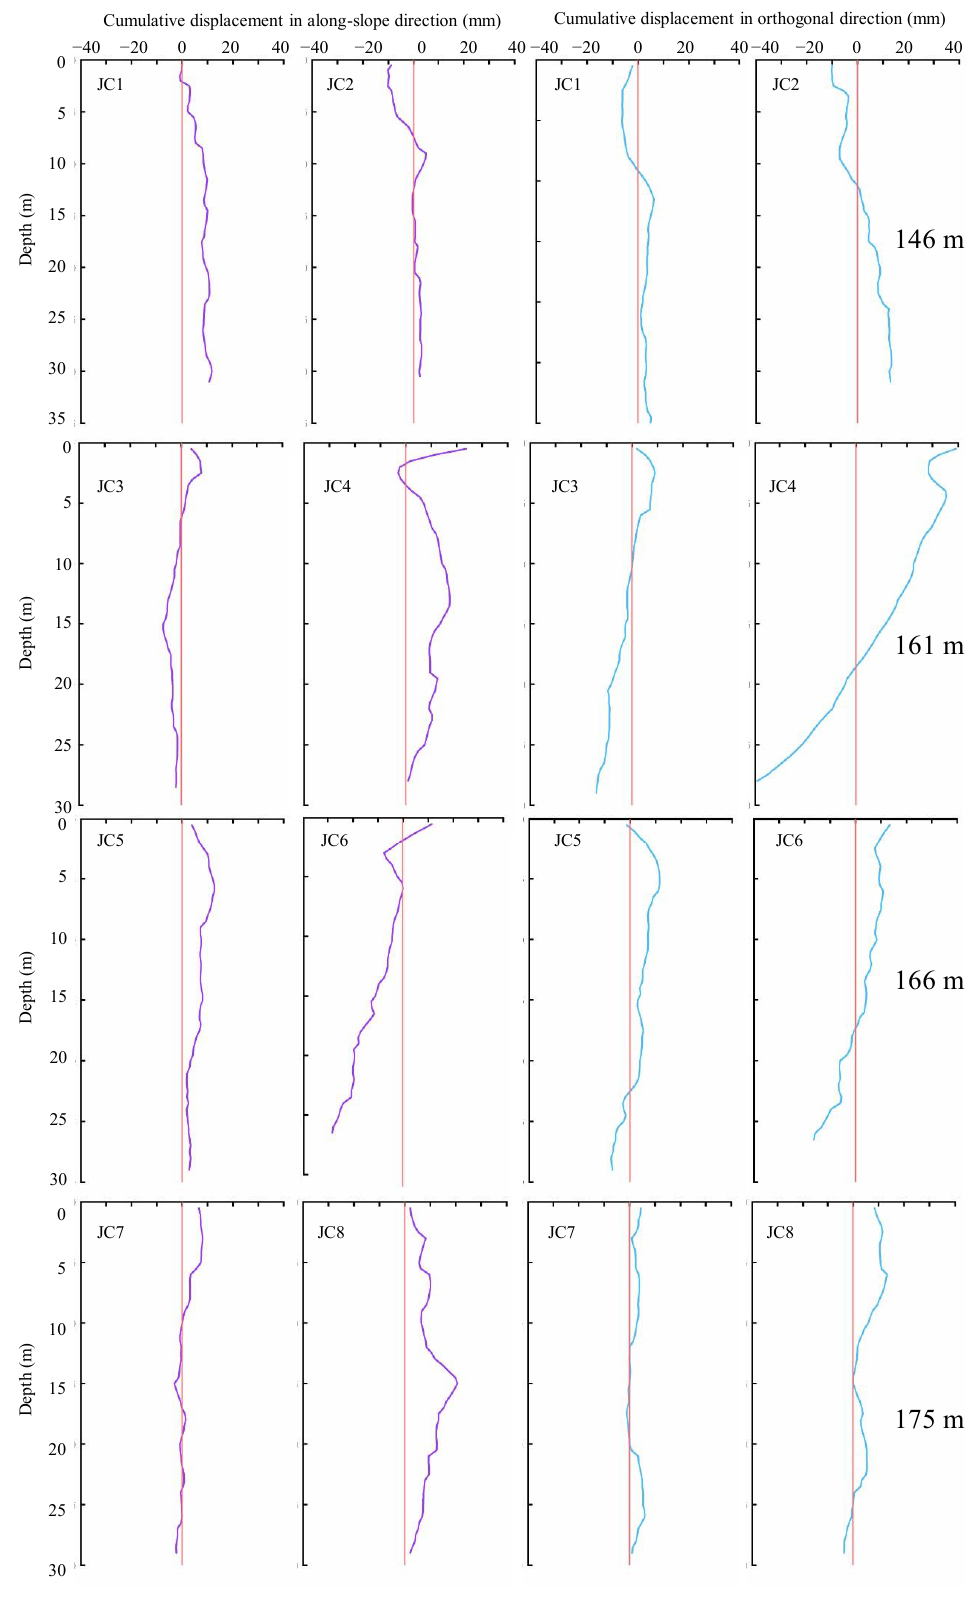
Figure 21. Changes in inclinometer monitoring data. Based on the comparison and analysis of the inclinometer observations during the two periods (Figure 21), there were different degrees of cumulative displacement in the